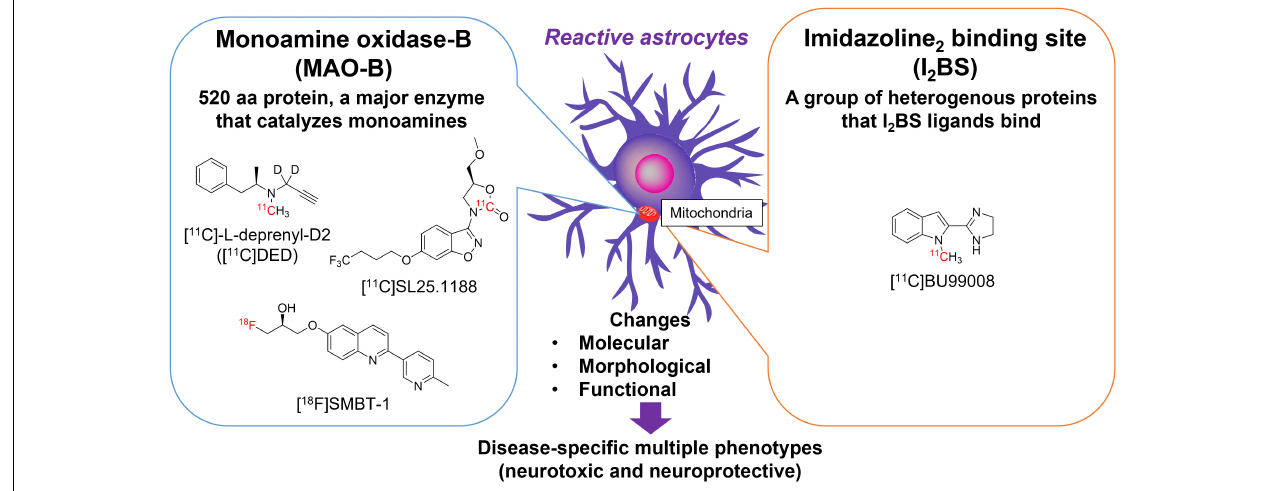
FIGURE 1 | Molecular targets for imaging reactive astrogliosis: monoamine oxidase-B (MAO-B) and imidazoline 2 binding site (I 2 BS). Chemical structures of selective PET tracers for MAO-B and I 2 BS tested in